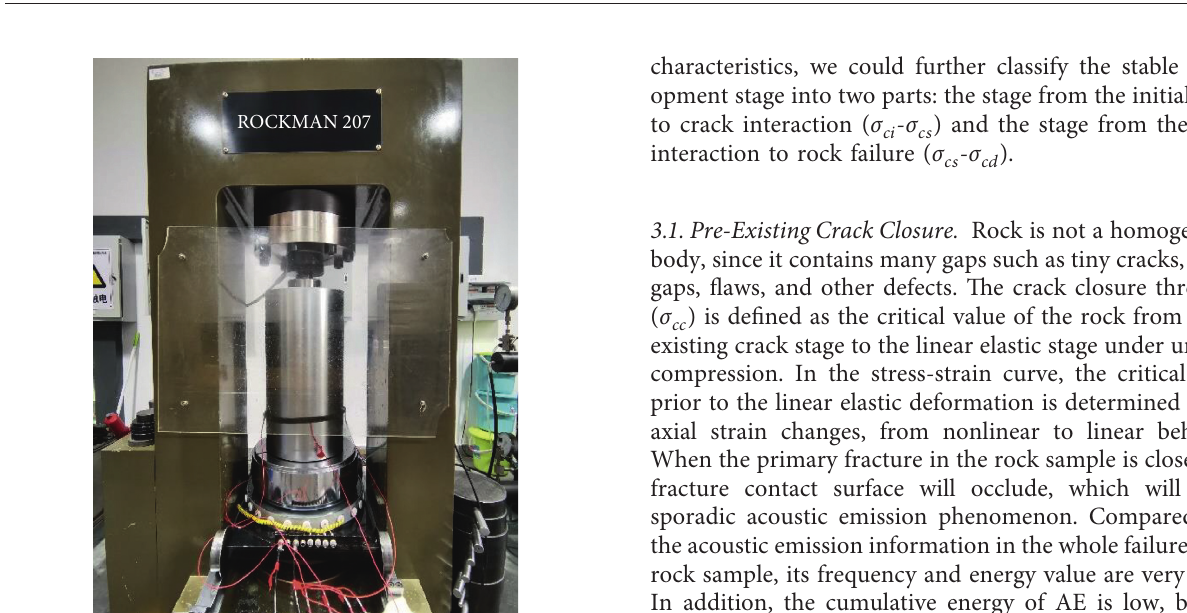
Table 1: Average size and parameters of physical and mechanical properties of granite samples. Specimens Granite rock